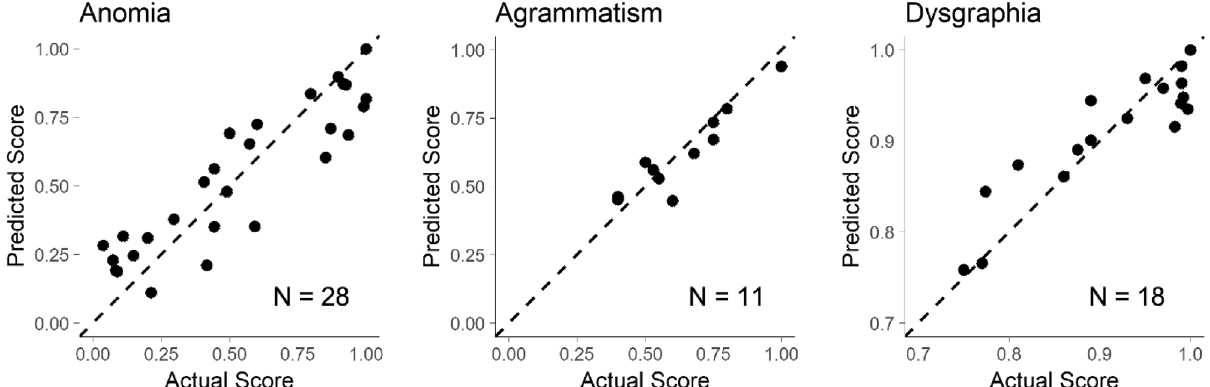
Figure 3. Predicting scores on the post-treatment TSM with GICA fALFF and pre-treatment TSM. Linear models which predict the TSM after therapy were constructed for each aphasia impairment (anomia, agrammatism, and dysgraphia) using a combination of the pre-treatment TSM and the fALFF for each GICA component. The dashed line represents a perfect prediction (predicted score = actual score). Black circles show the predicted score for each patient using LOOCV. For the agrammatism model, the circles represent median values across 1000